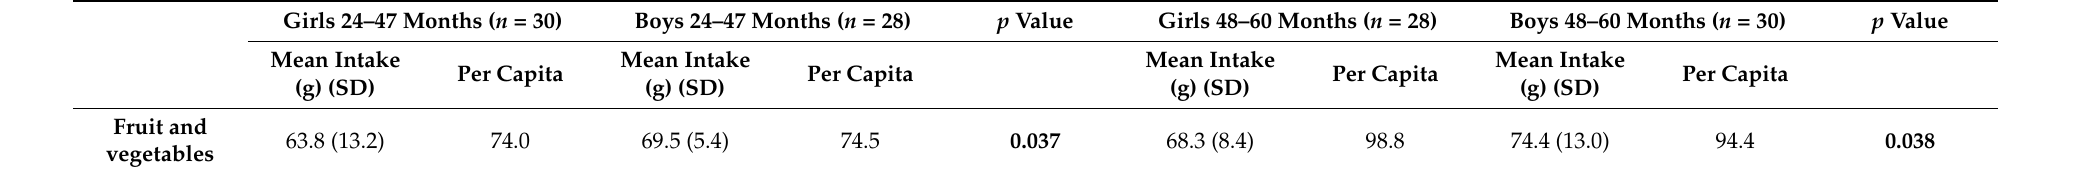
Table 2. Mean fruit and vegetable intake for all participants ( n =